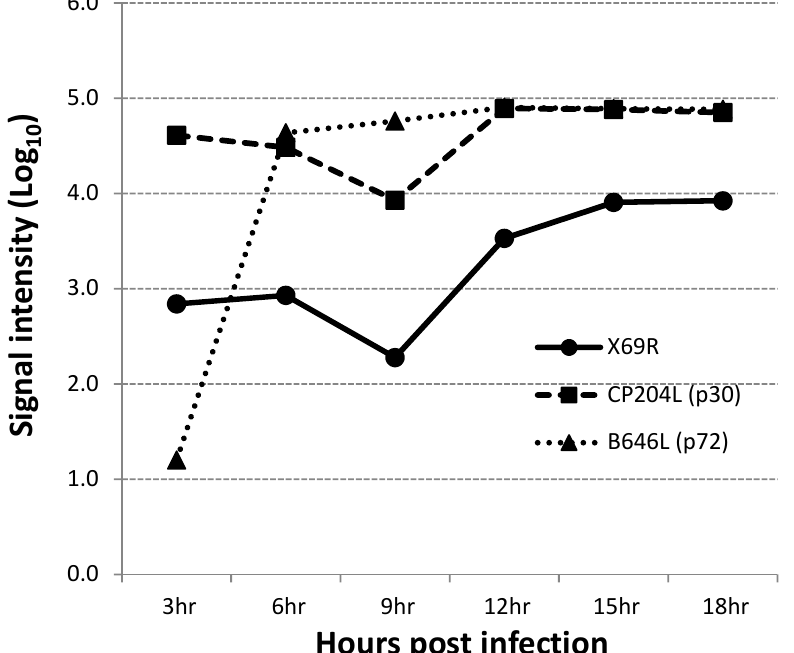
Figure 2. Time course of X69R gene transcriptional activity. Averaged microarray signal intensities (photons per pixel) of ASFV X69R, CP204L, and B646L open reading frame (ORF) RNA prepared from ex vivo pig macrophages infected with ASFV at 3, 6, 9, 12, 15, and 18 hpi.